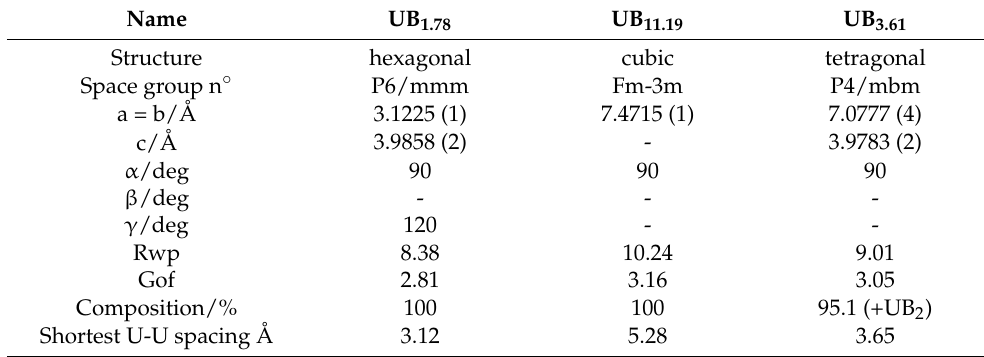
Table 2. Structural parameters.